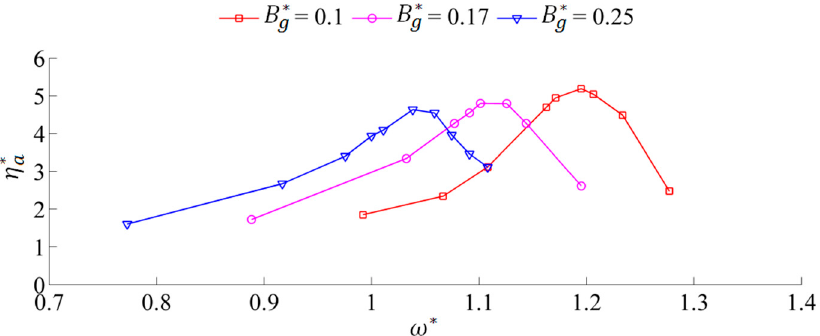
Figure 17. The elevation amplitude inside the gap η ∗ a versus the incident wave frequency ω ∗ of cases Figure 17 . The elevation amplitude inside the gap 𝜂 (cid:3028)∗ versus the incident wave frequency 𝜔 ∗ of with di ff erent gap width B ∗ g in the present cases with different gap width 𝐵 (cid:3034)∗ in the present simulations.